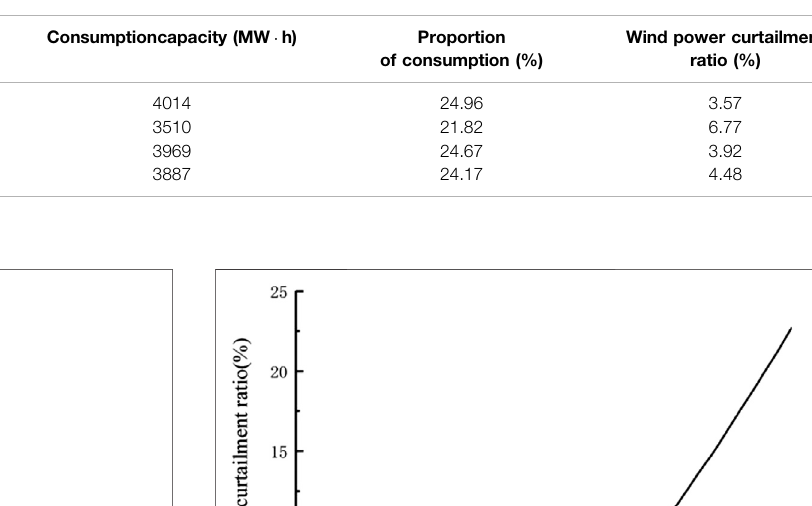
TABLE 4 | Calculation results of consumption capacity.